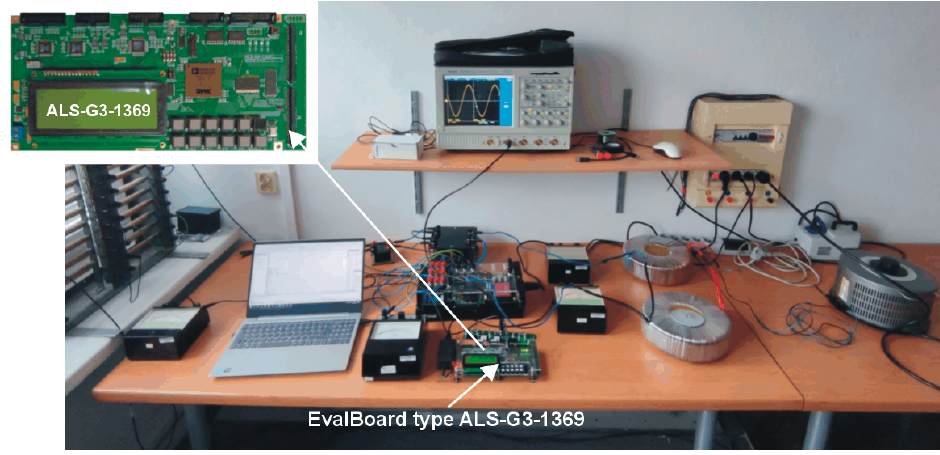
Figure 5. General view of the laboratory stand.